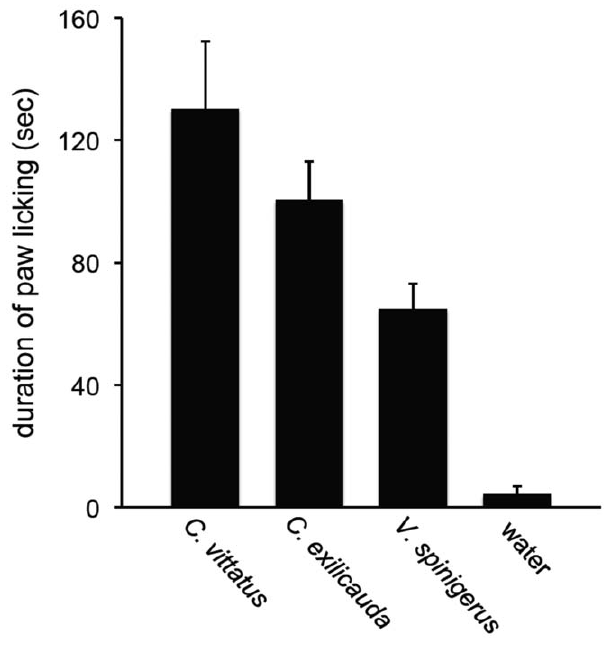
Figure 1. Mean ( + 1SE) duration of paw licking for Musmusculus injected with scorpion venom or water. Samples of whole, soluble venom from three scorpion species induced more hind-paw licking in M. musculus than the water control during a ten-minute test period following the injection (F=37.25; df=1, 28; P , 0.0001). However, Centruroides’ venom induced more paw licking than V. spinigerus venom (F=9.49; df=1, 28; P=0.0046). There was no statistical difference in the duration of paw licking induced by C. vittatus and C. exilicauda venom (F=2.47; df=1, 28; P=0.1275).